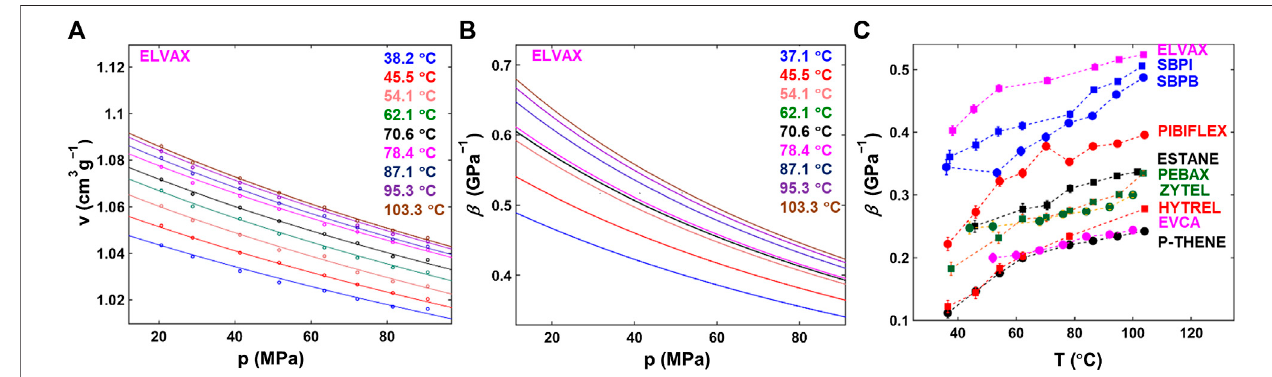
FIGURE 2 | Mechanical property measurement. (A) pvT isotherms (symbols) fi tted with the Tait equation of state (solid lines) for a representative material (ELVAX). (B) Temperature-dependent isothermal compressibility calculated using the isotherms plotted as a function of pressure for ELVAX. (C) Isothermal compressibility of all materials as a function of temperature at 50 MPa